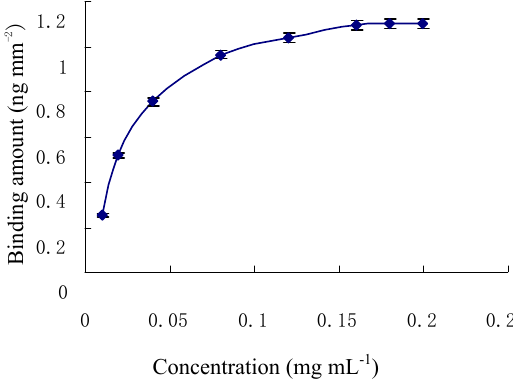
Figure 2. Optimization of ET-1 immobilization on the IAsys cuvette (pH7.4